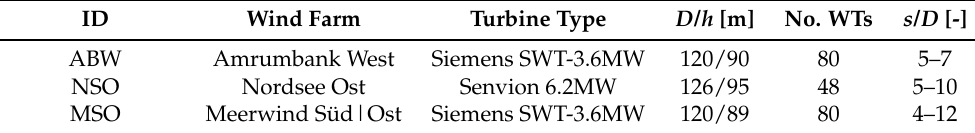
Figure 1. Existing wind turbines (black dots) and planned wind farm areas (blue lines) in part of the German exclusive economic zone (EEZ) of the North Sea. The N-4 wind farm cluster is indicated within the inlet. The positions of the two met masts FINO1 and FINO3, respectively, are marked by red dots. Table 2. Properties of the wind farms within the N-4 cluster (cluster name is defined according to the offshore areas specified by the German Federal Hydrographic Agency (BSH), wind farm ID, wind farm name, the turbine type within the wind farms, their rotor diameter ( D ) and hub height ( h ), number of wind turbines (No. WTs) and the range of spacing between wind turbines ( s / D ).